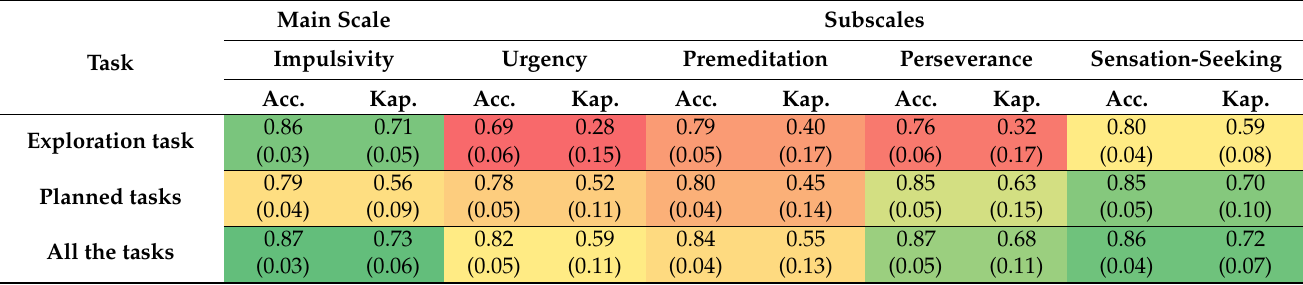
Table 4. Accuracy of prediction in each scale and subscale for a combination of